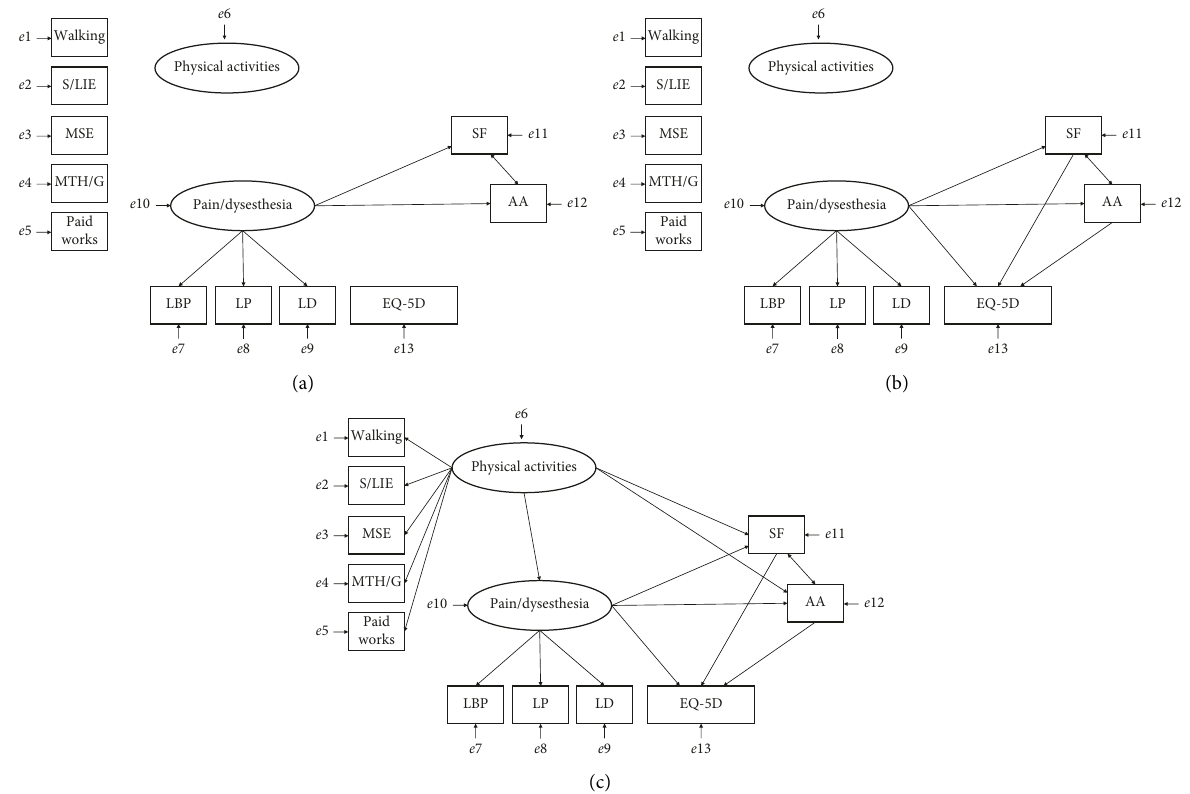
Figure 1: Process of constructing a hypothetical model of the relationship between physical activities and pain/dysesthesia and kinesi- ophobia. S/LIE: stretching and light-intensity exercises; MSE: muscle strength exercises; MTH/G: maintenance tasks of the house and garden including kitchen garden; SF, somatic focus; AA, activity avoidance; EQ-5D, EuroQol